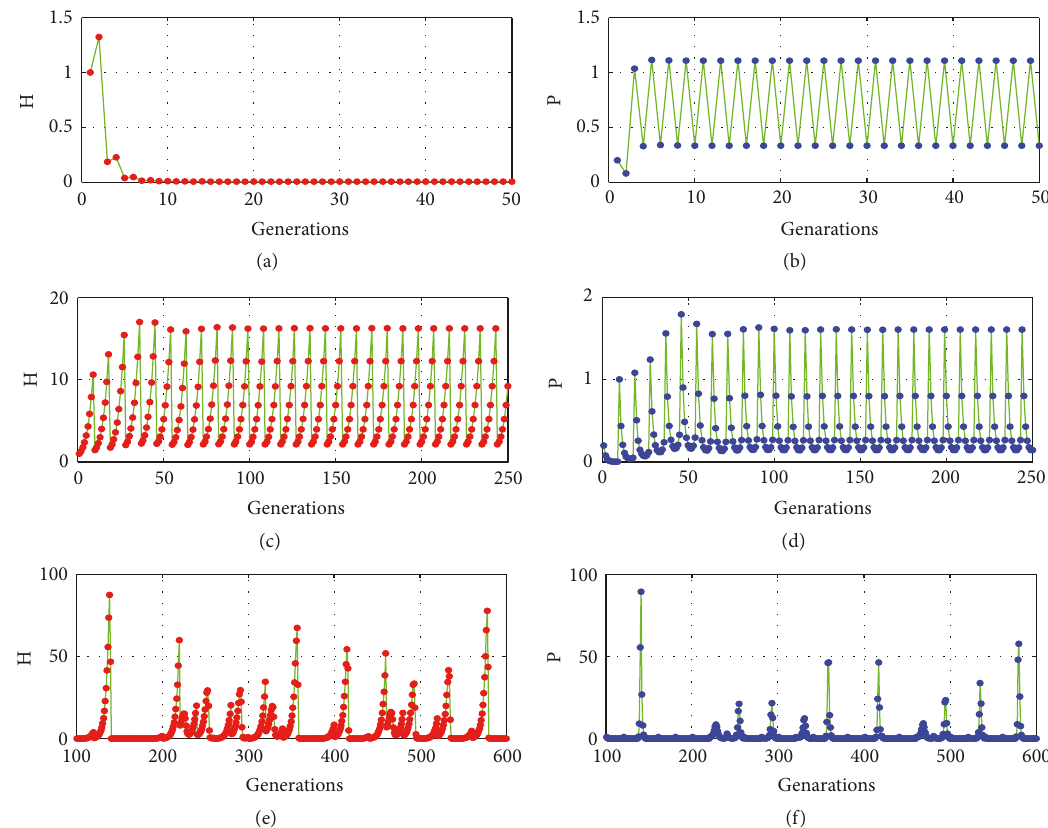
Figure 2: Three types of solutions for model (3). (a-b) HF periodic solution with 9 = 2 ; (c-d) HP periodic solution with 𝑞 = 9 ; (e-f) HO solution with 𝑞 = 20 . Parameters are fixed as 𝑟 = 0.3 , 𝑎 = 0.1 , 𝑞 𝑚𝑎𝑥 1 = 0.9 , 𝜃 1 = 0.01 , 𝑞 𝑚𝑎𝑥 2 = 0.4 , 𝜃 2 = 0.5 , 𝜏 = 1 , and (𝐻 0 ,𝑃 0 ) =